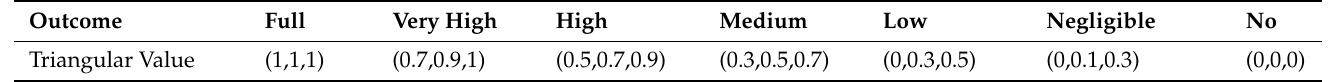
Table 4. A fuzzy scale of 7 points was used in the